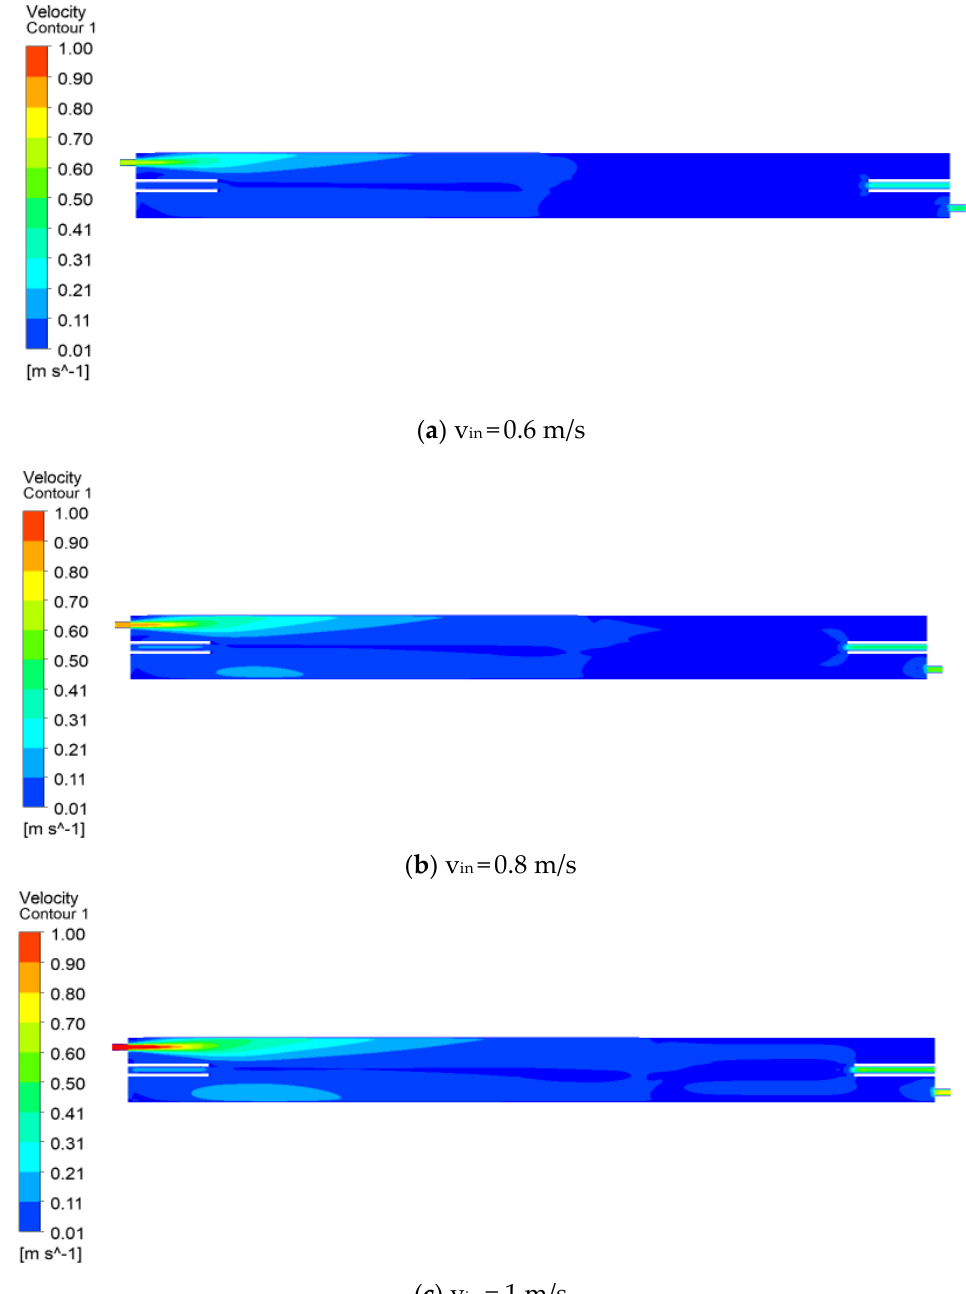
Figure 7. Velocity contour on X = 0 section.